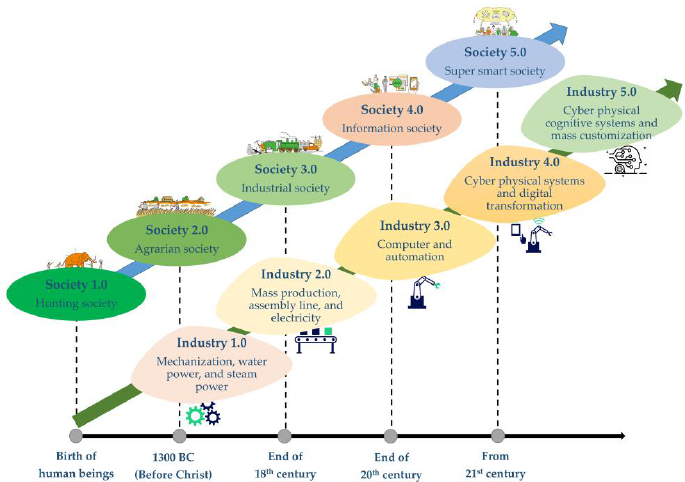
Figure 7. Timeline of industrial and societal transformations [203 – 208].